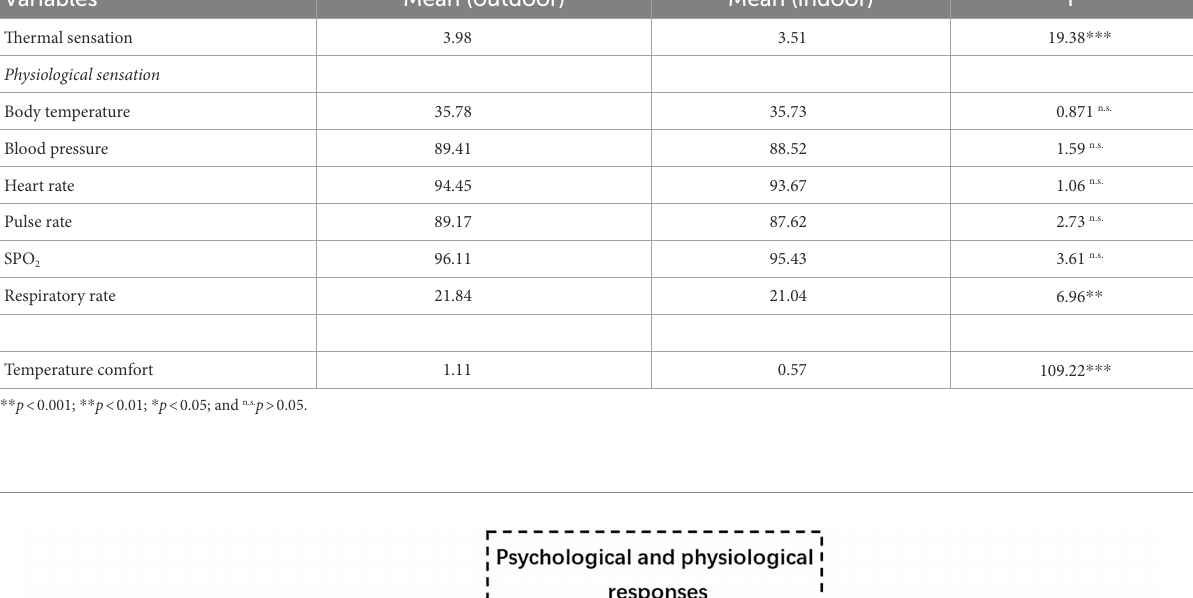
FIGURE 3 Mediating effects.